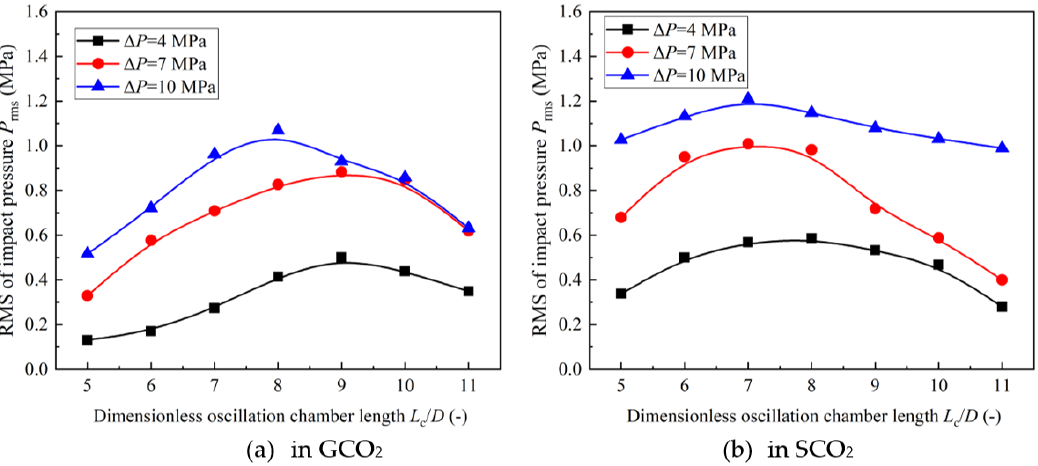
Figure 7. RMS value of impact pressure as a function of the chamber length: ( a ) in GCO 2 and ( b ) in SCO 2 . Experimental conditions: ∆ P = 4–10 MPa, 5 ≤ L c / D ≤ 11, and P a = 6 or 8.5 MPa.